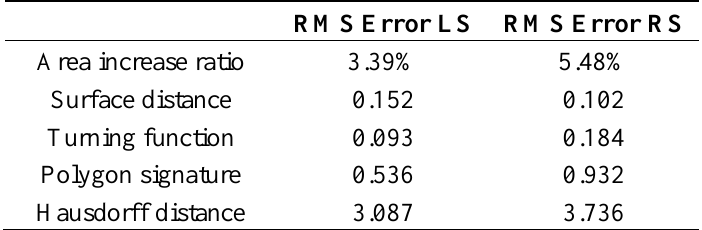
Table 1. Root Mean Square errors (RMS) for Least Squares conflation (LS) and Rubber Sheeting conflation (RS) compared to initial data, for five shape comparing measures and 200 features.